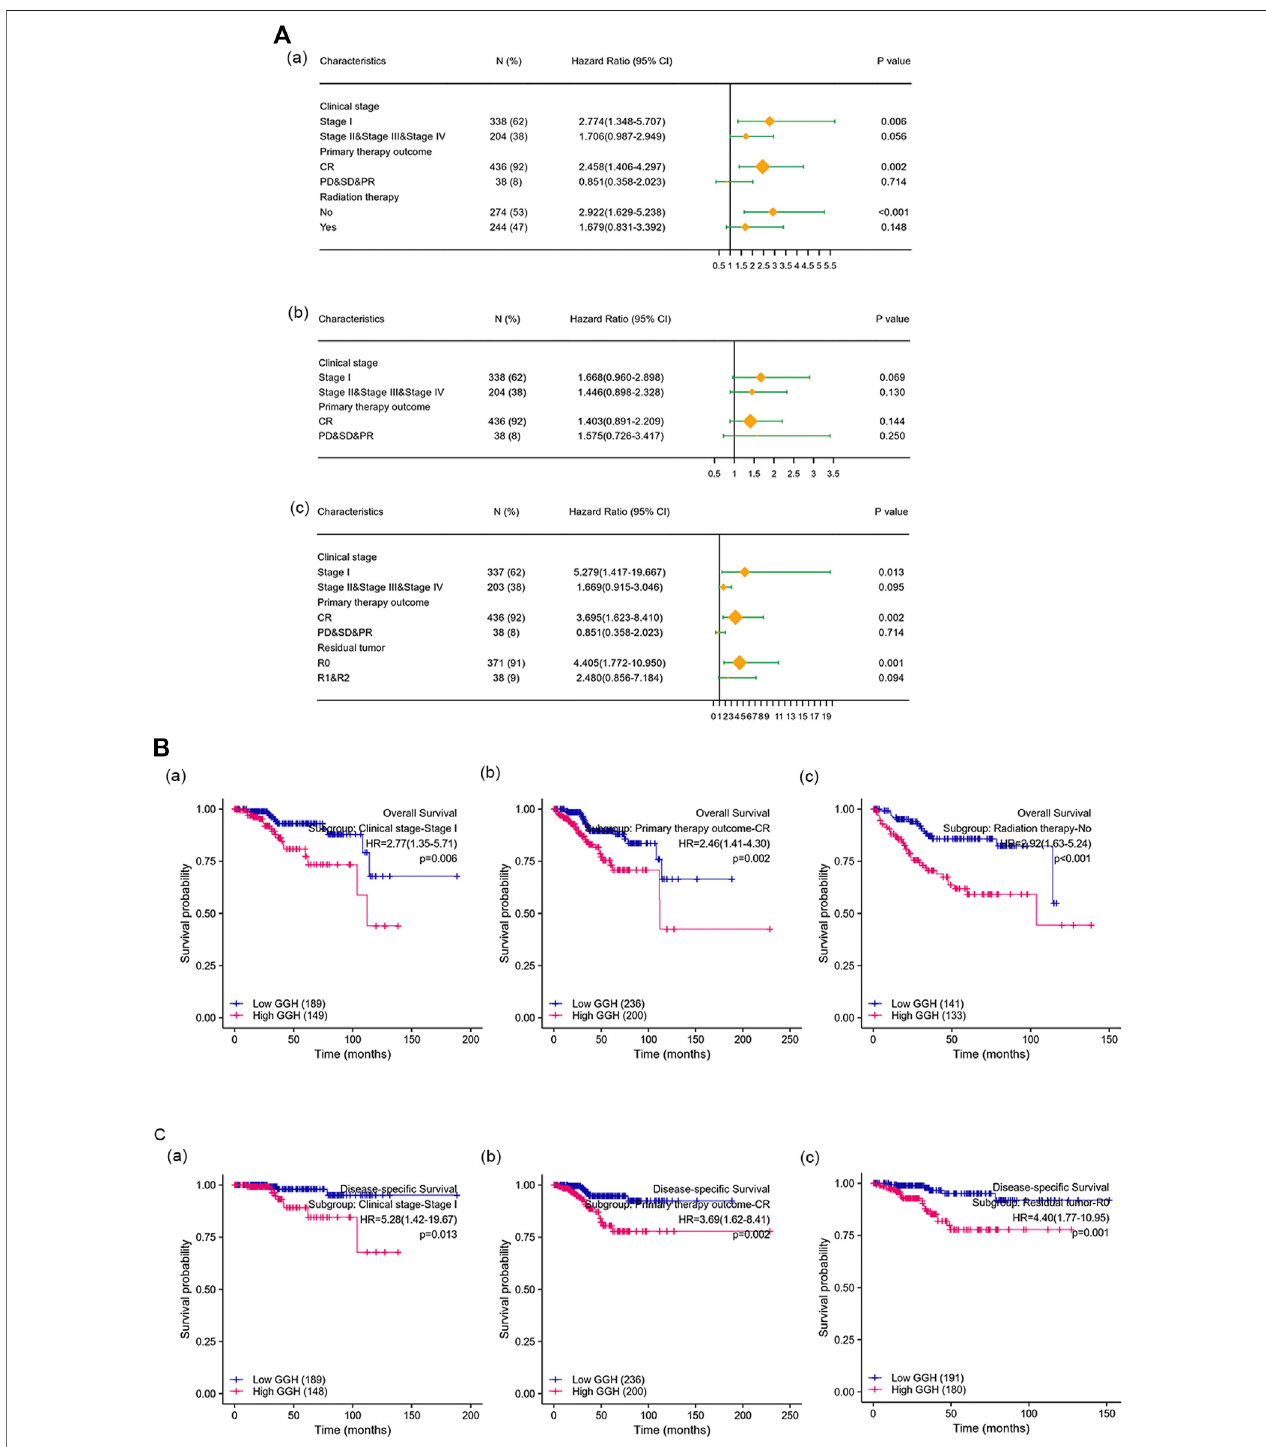
FIGURE 4 | The prognostic value of GGH for survival prediction within speci fi c clinicodemographic subgroups (chosen according to signi fi cant associations by multivariateCoxanalysis). (A) Forestplotsoftheprognosticvalueineachsubgroup forOS(a),PFI(b), andDSS(c). (B – C) Kaplan-Meier analysisofOSand DSSforeach